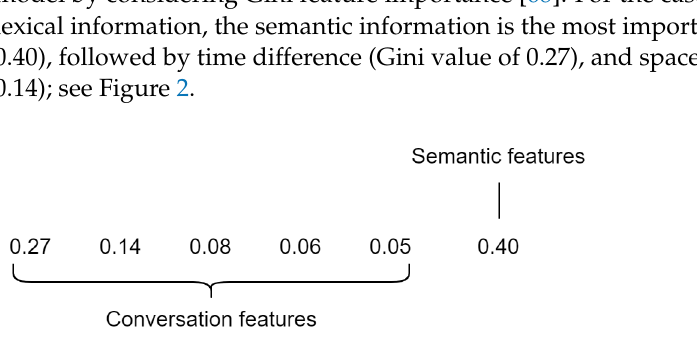
Figure 2. Gini feature importance for random forest without string